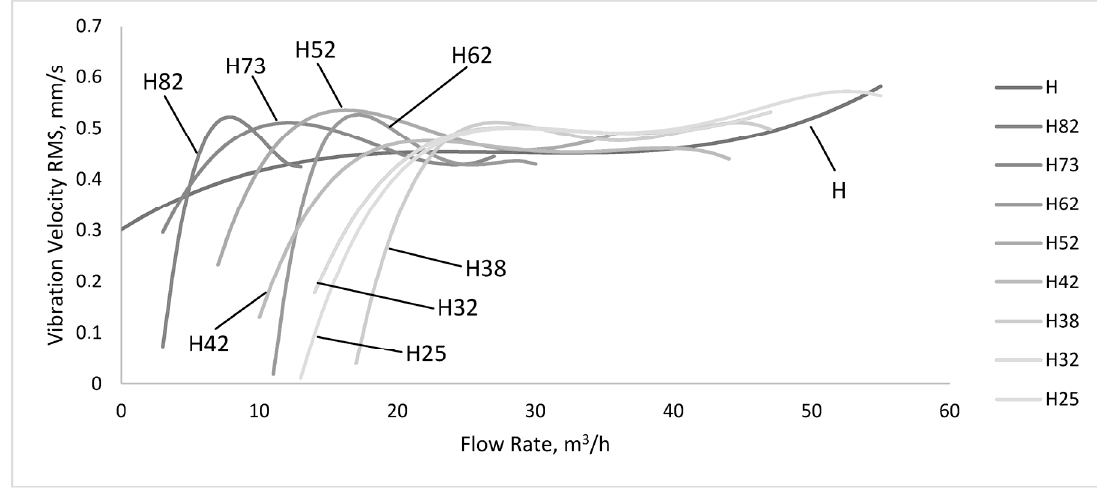
Figure 4. Vibration velocities corresponding to the point modification of the characteristic curve when introducing different amounts of air into the fluid circulated.